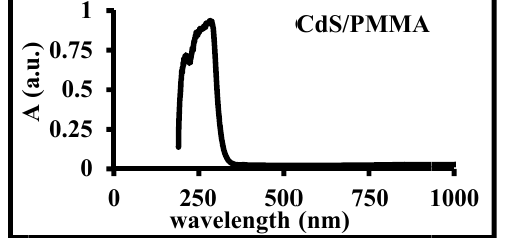
Fig. 2: UV- CdS/PMMA t thin